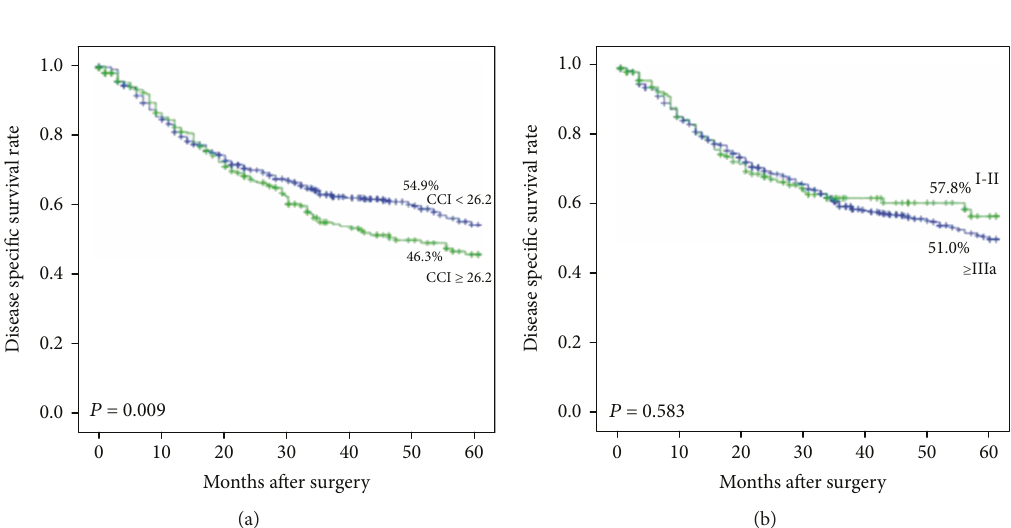
Figure 2: Kaplan-Meier curves of patients with mild and severe postoperative pneumonia according to CCI and CD grade. (a) Disease- speci fi c survival of patients with postoperative complications measured by CCI ( p = 0 009 ). (b) Disease-speci fi c survival of patients with postoperative complications measured by C-D classi fi cation ( p = 0 583 ).